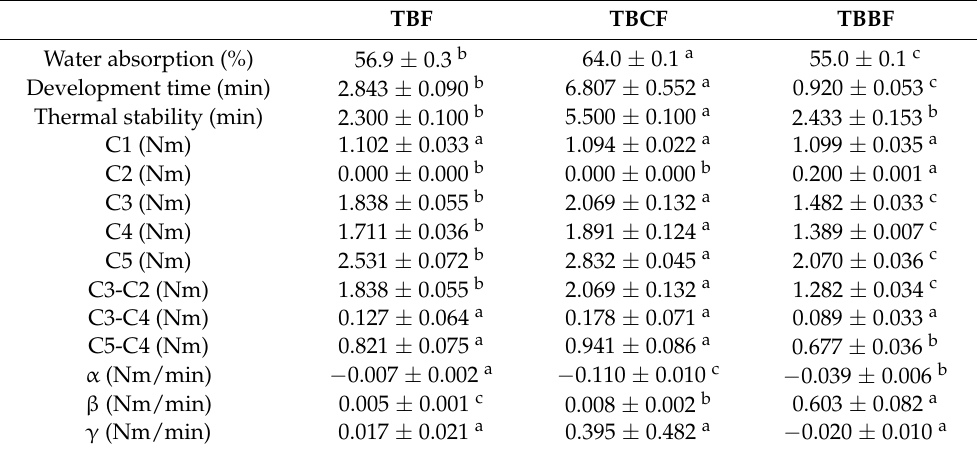
Figure 4. Mixolab profiles of TBF, TBCF and TBBF (TBF: Tartary buckwheat flour; TBCF: Tartary buckwheat core flour; TBBF: Tartary buckwheat bran flour). Table 4. Parameters values of Mixolab curves of all samples.